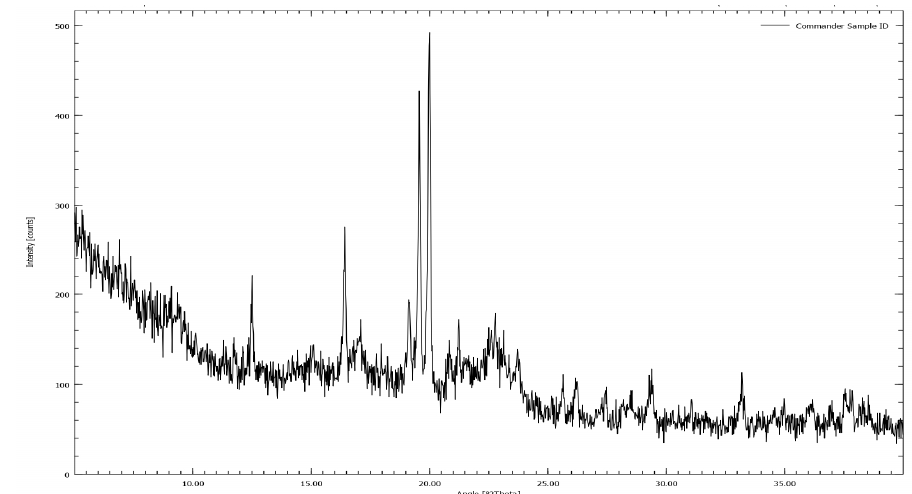
Figure 5. shows the X-ray Diffraction (XRD) Spectra of the fermented lovastatin. Figure 5. Shows the X-ray Diffraction (XRD) Spectra of the fermented